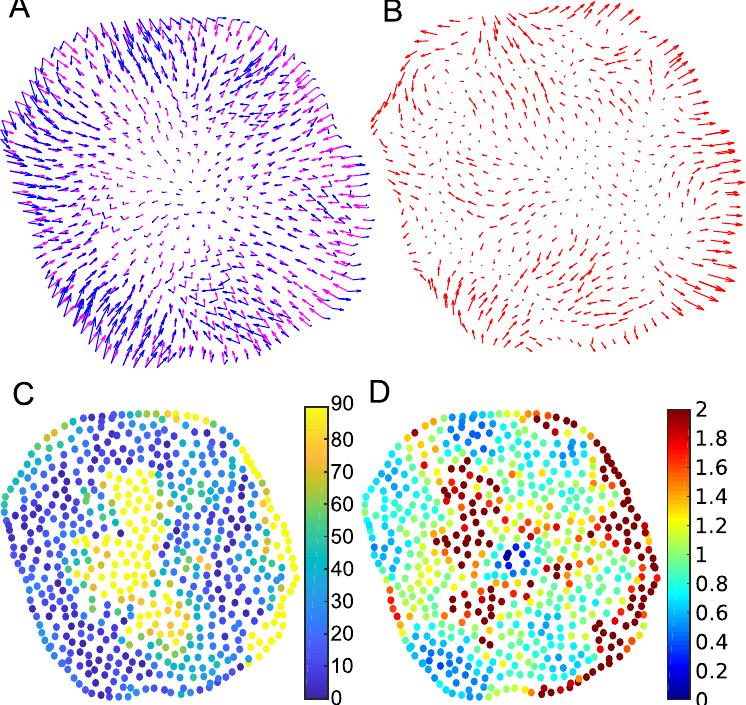
Fig 5. Comparing predicted forces to experimental data for a round cell. (A) Predicted CPM force fields (magenta arrows) and experimental data (blue arrows) (B) Difference of CPM force field and experimental force field (C) directional deviation (angle between predicted and experimentally observed force vectors), dark blue means forces align well. (D) relative magnitudes of the force fields, green means similar magnitude. Parameter values are given in Table S1 Table. See also S11 and S15